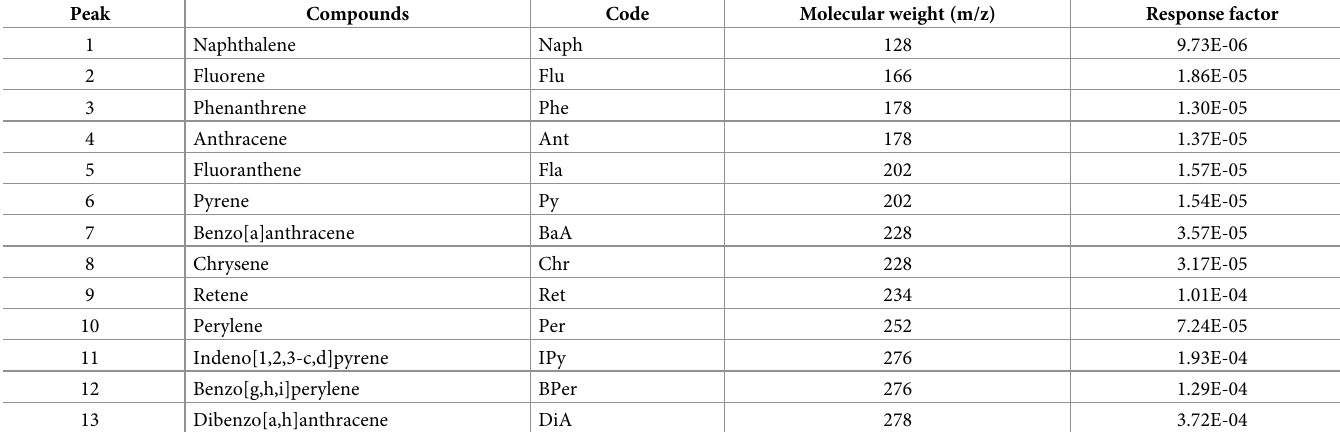
Table 1. Measured polycyclic aromatic hydrocarbons (PAHs) identified based on the authentic reference